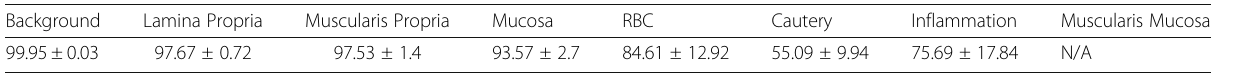
Table 4 7-fold cross validation of dataset S1 using He Normal initializer and a 12 layer U-net architecture. Expressed a mean accuracy and standard deviation